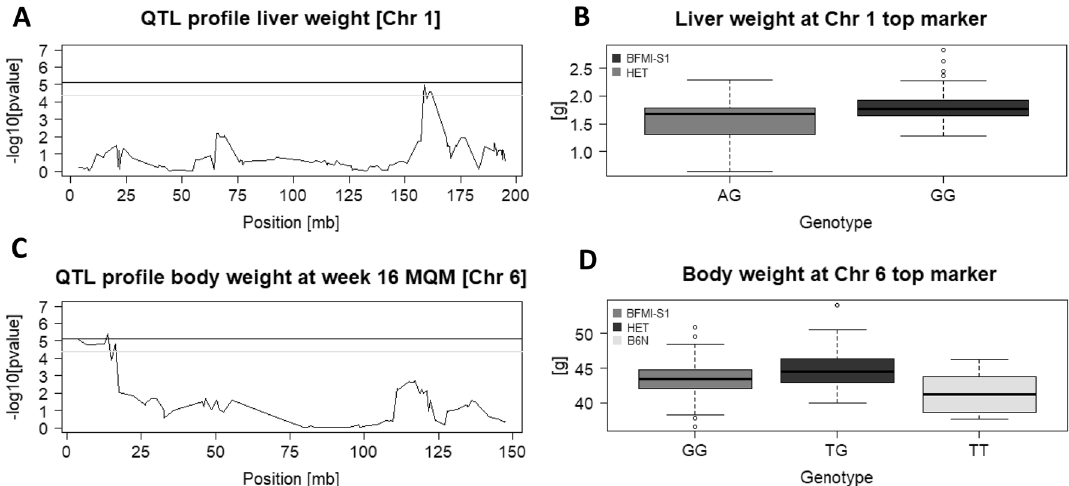
Figure 1. ( A ) QTL mapping curve of the locus on chromosome 1 for liver weight. The black (1%) and grey (5%) horizontal lines mark the significance thresholds; likelihood ratios above the black line are formally highly significant (LOD > 5.1), likelihood ratios above the grey line are formally significant (LOD > 4.4). ( B ) Boxplots for two genotype classes (BFMI-S1, BFMI861-S1 homozygous; HET, heterozygous) at SNP gUNC2036998 which is located at the top position for liver weight. (C) QTL mapping curve on chromosome 6 for body weight at week 16 after performing MQM. (D) Boxplots for all three genotype classes (BFMI-S1, BFMI861-S1 homozygous; HET, heterozygous; B6N, C57BL/6 N homozygous) at SNP gUNC10595065 which is located at the top position for body weight at week 16 after performing